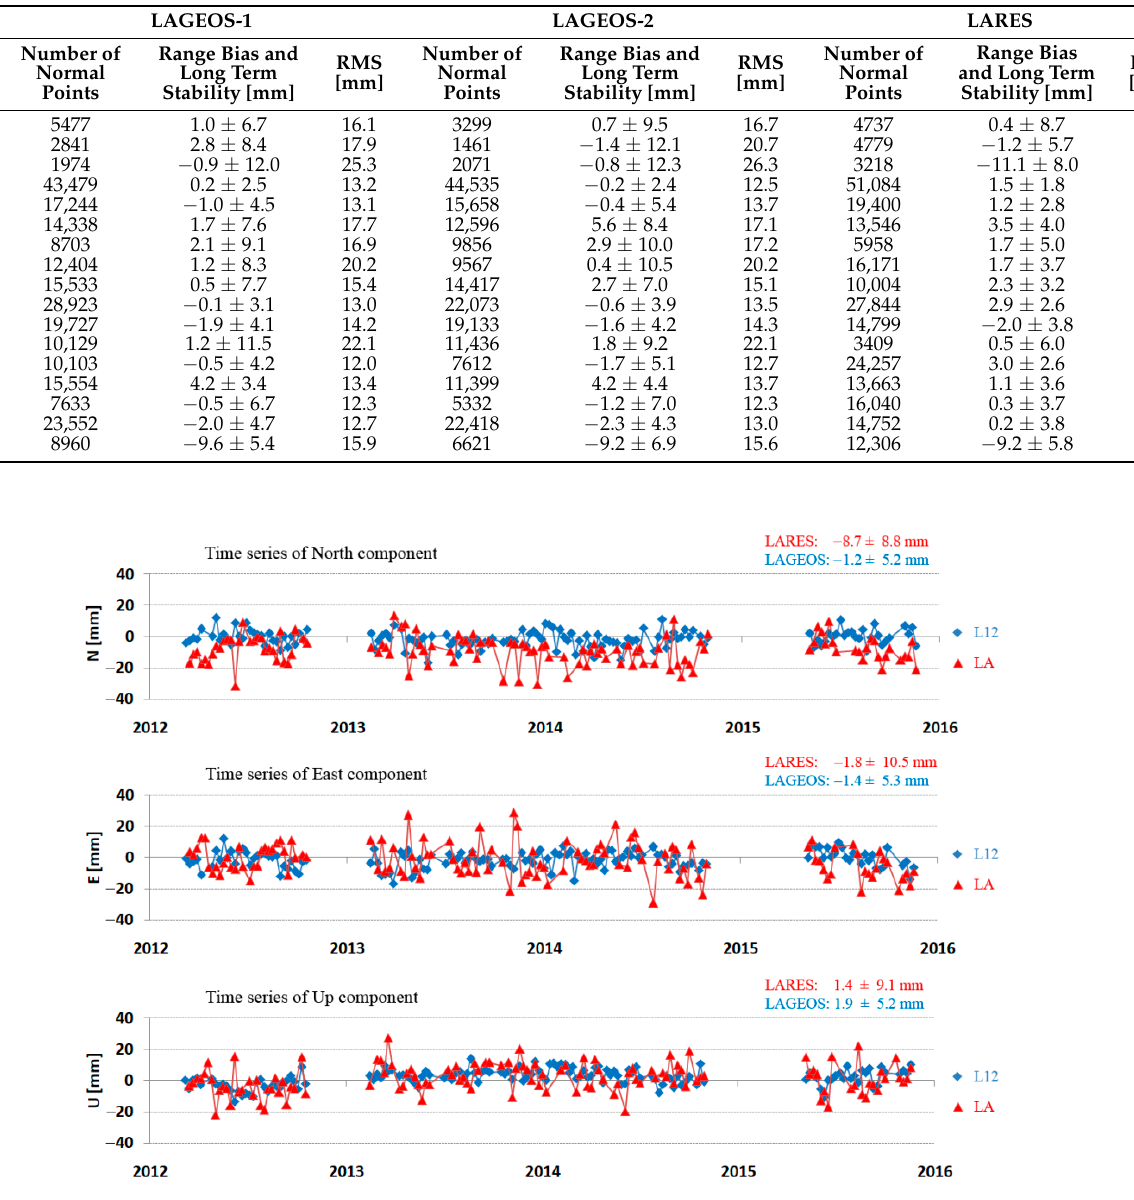
Figure 5. Time series of the North, East, and Up components for Zimmerwald station (7810) for LARES (red) and LAGEOS (blue) in the period from 2012 to 2015.